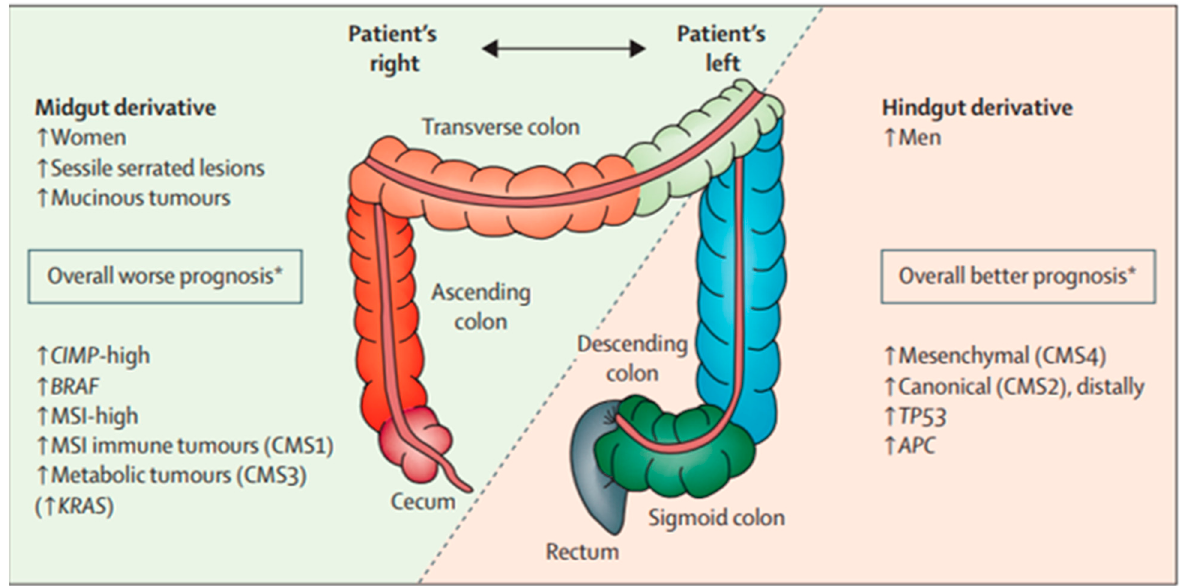
Figure 1. Relationship between clinical, histologic, and molecular differences of colorectal cancer and prognosis [4].